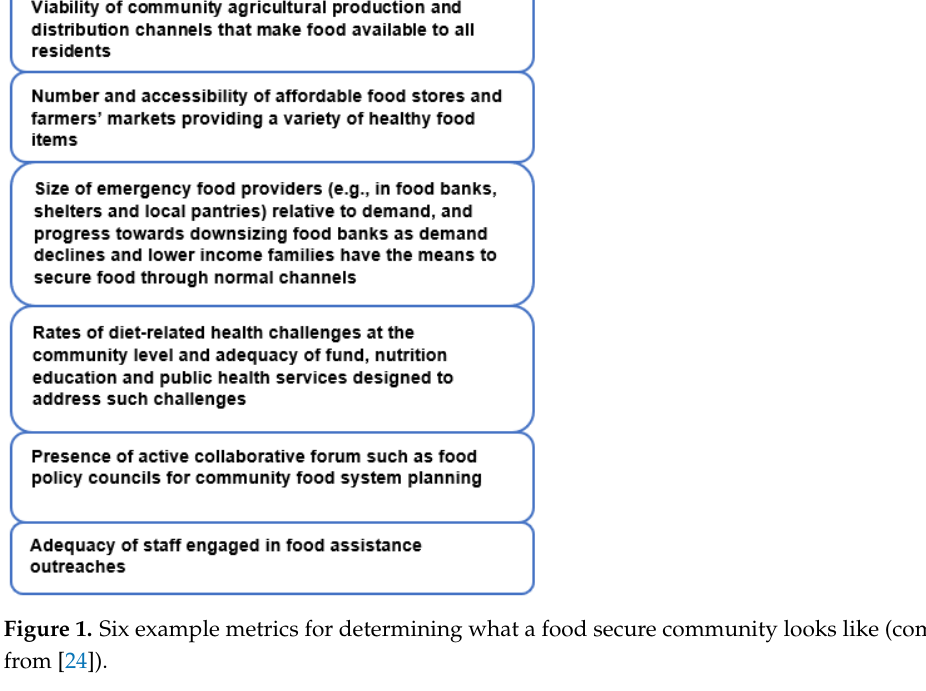
Table 1. An overview of the ways in which GBV-related harms to community food security manifest. CFS Core Domains Description: GBV Entry Point